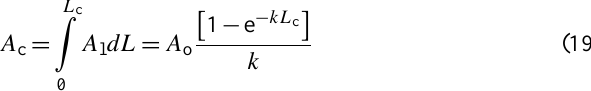
Lower temperature parameter Upper temperature